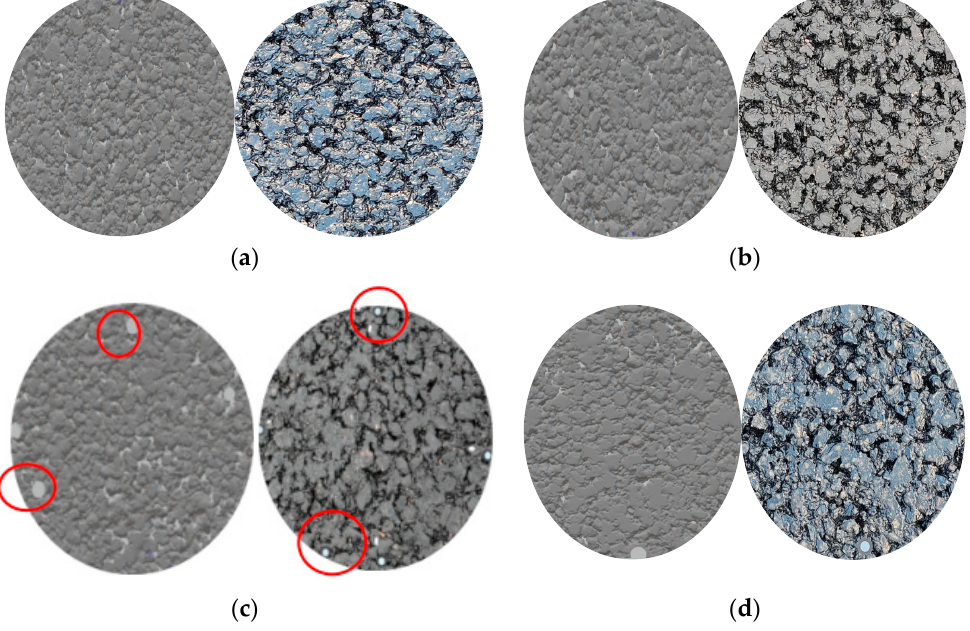
Figure 15. Scanned and actual images of the two mixtures (The red circles show the positioning holes.). ( a – c ) Steel slag–asphalt mixture; ( d ) basalt–asphalt mixture.